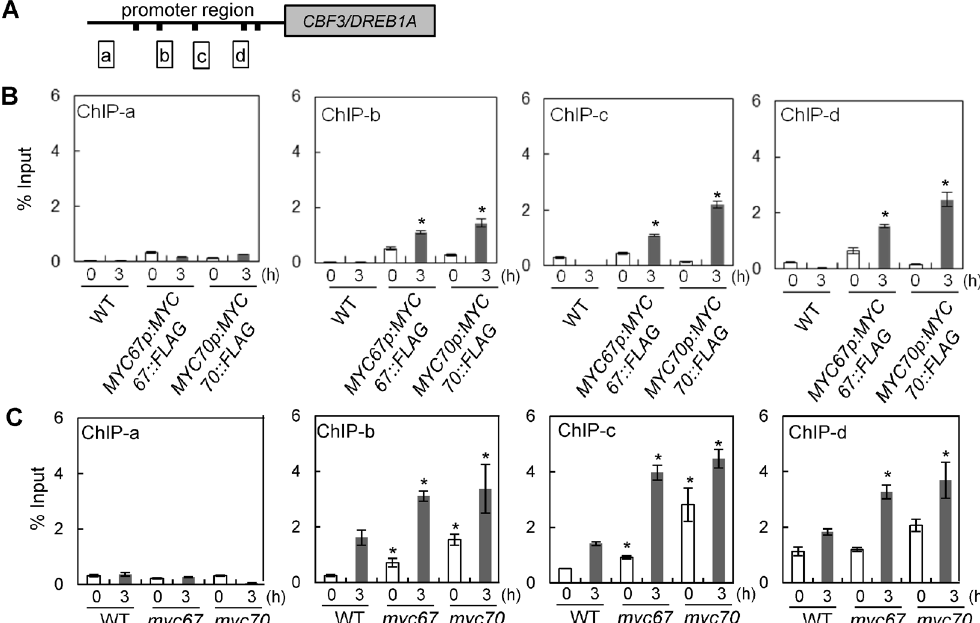
Figure 6. MYC67 and MYC70 were able to bind to the promoter region of CBF3 / DREB1A . ( A ) A schematic representation of the promoter region of CBF3 / DREB1A and the region that was amplified after the ChIP analysis. ( B ) The wild-type and transgenic plants used for the ChIP assay were treated at 4 °C for 3 h. The immunoprecipitated DNA with anti-DYKDDDDK tag monoclonal antibody was quantified by quantitative PCR using primers in the promoter region. The data are the average of technical triplicates for the quantitative PCR (mean ± SD). ( C ) The wild-type and myc mutants were treated at 4 °C for 3 h, and ChIP analysis was performed with anti-ICE1